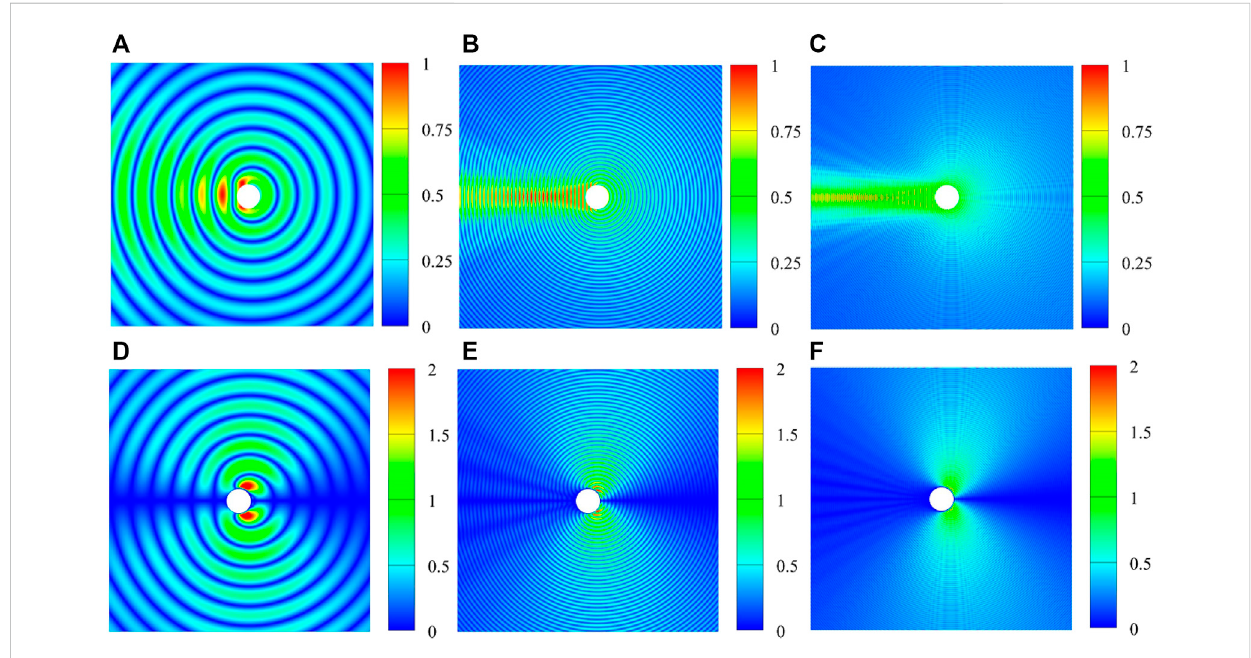
FIGURE 4 Scattering electric and magnetic fi eld distribution under TE polarization with θ sca =0. (A) Electric fi eld, f =100MHz; (B) electric fi eld, f =500MHz; (C) electric fi eld, f =1000MHz; (D) magnetic fi eld, f =100MHz; (E) magnetic fi eld, f =500MHz; (F) magnetic fi eld, f =1000 MHz.